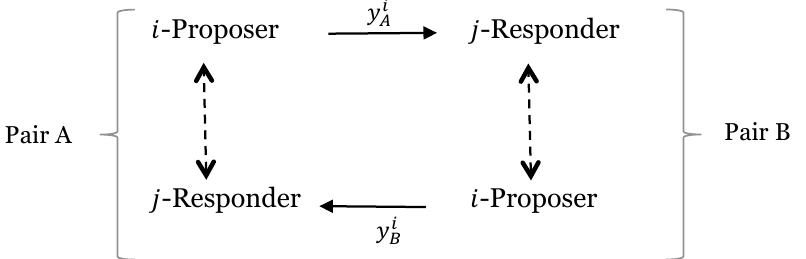
Figure 2. Matching scheme of type i and j proposer candidates in two matched pairs (A and B). Dashed arrows represent the conditional choice relation within each pair (each candidate i = e , o states two adjusted offers, y + and y − , in case the intended offer of the other candidate is larger, y i < y j , or smaller, Figure 1 : Random selection whether i or j is endowed and offering in both pairs; i i y i > y j , than the own one) while actual offers are represented by solid arrows (with i , j = e , o and i (cid:54) = j i,j=e,o with ! ≠ ! . Dash-arrows refer to conditioning while actual offers are represented by arrows.